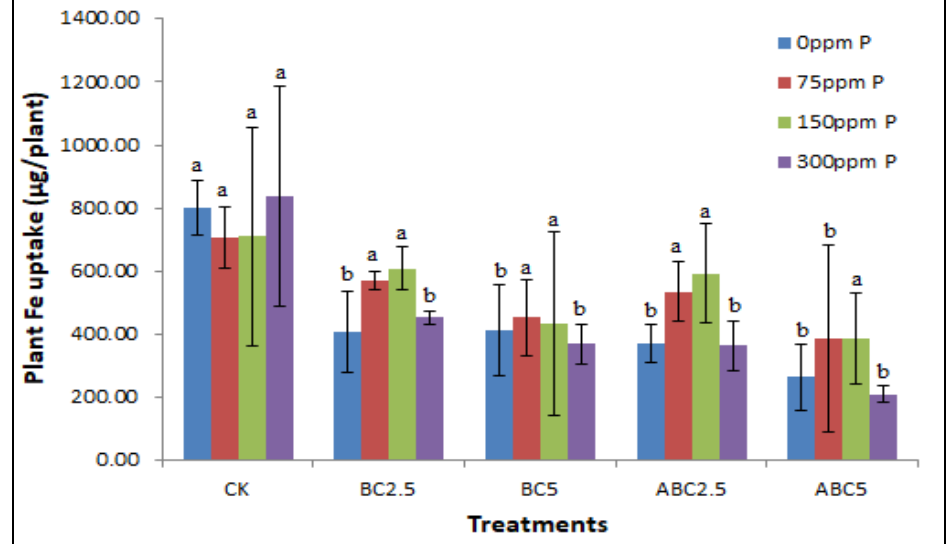
Figure 11. Effects of BC and ABC applied at different rates with different P fertilizer application rates on Plant Fe uptake ( μ g/plant). Means with different letters within each fertilizer rate across each treatment indicate significant differences according to the least significant difference (LSD) test at p < 0.05. CK = Control, BC2.5 = Biochar added at 2.5% w / w , BC5 = Biochar added at 5% w / w , ABC2.5 = Acidified biochar added at 2.5% w / w , and ABC5 = Acidified biochar added at 5% w / w .